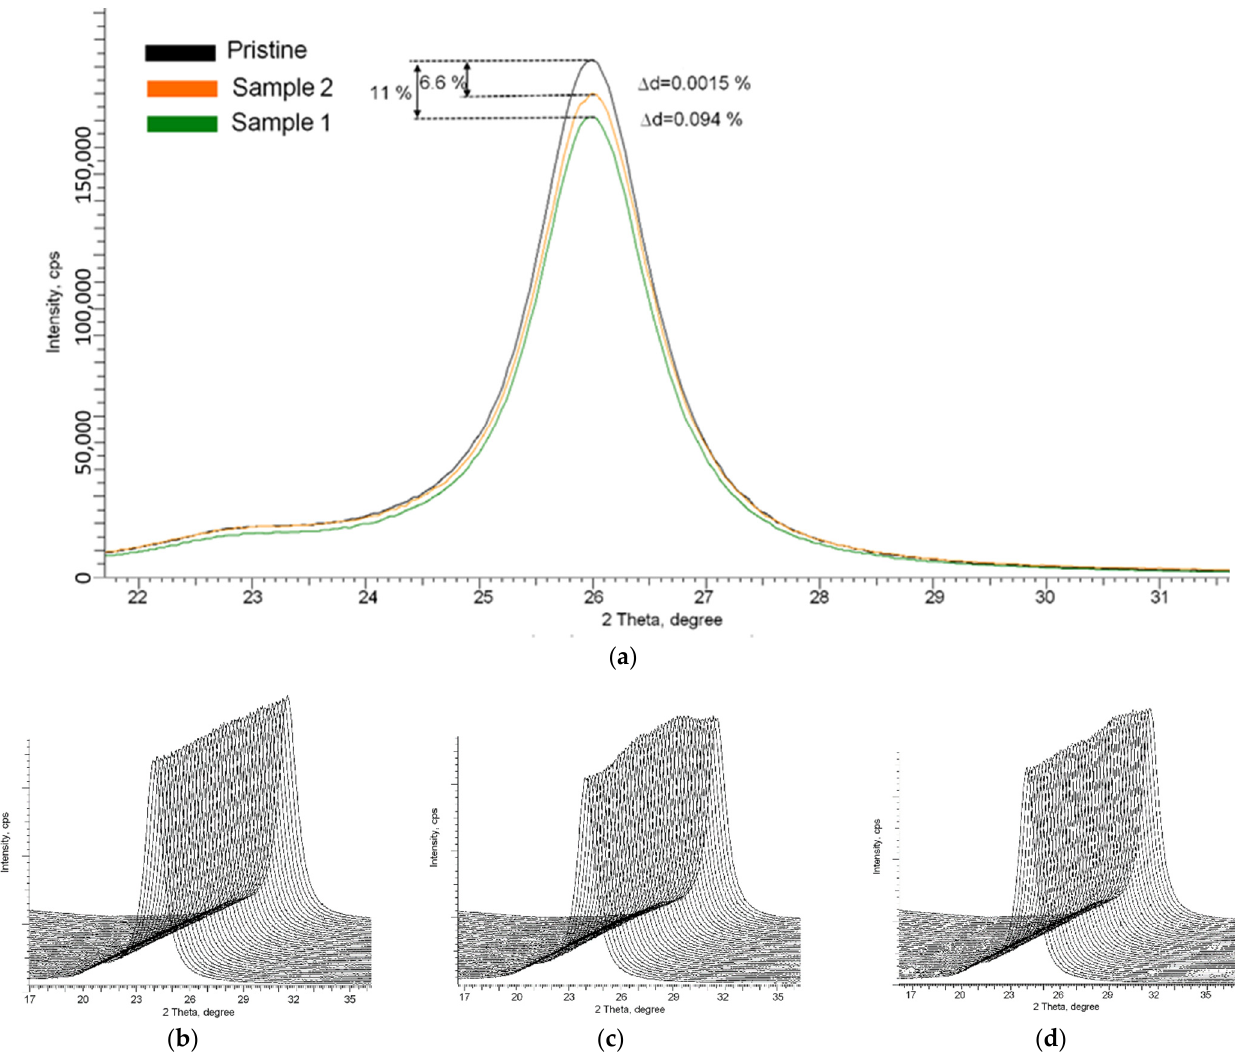
Figure 5. X-ray diffraction patterns of the studied samples of SSNTD films placed in residential premises: ( a ) comparative diffraction patterns of samples after detection of α -particles; representa- tion of X-ray diffraction patterns in survey geometry φ = 0–360°: ( b ) initial sample; ( c ) sample 2; ( d ) sample 1.